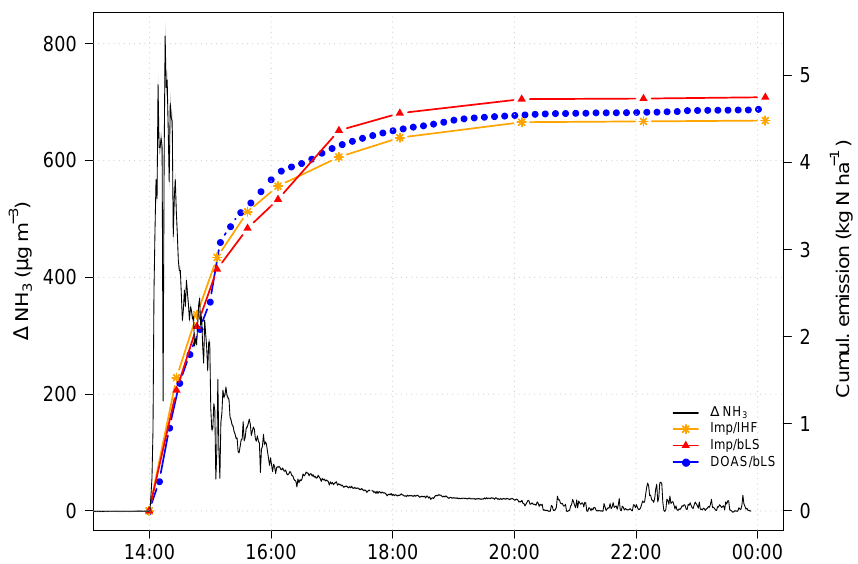
Figure 8. Horizontal NH 3 concentration differences measured by the miniDOAS and cumulated NH 3 emissions (coloured) caused by slurry application to grassland (E1, Table 1); emissions were determined by miniDOAS–bLS and impinger–bLS as well as impinger–IHF (see Sect. 2.4 and Häni et al., 2016); concentration difference uncertainty range (grey) represents the upper limit of 95% confidence. Note that these values were determined based on turbulence data from a Gill WindMaster Pro ultrasonic anemometer that has a systematic bias in the vertical wind components (see www.gillinstruments.com; Key Note Series Number: KN1509v3) that was not corrected. Considering the correction increases the cumulated emission by ca.